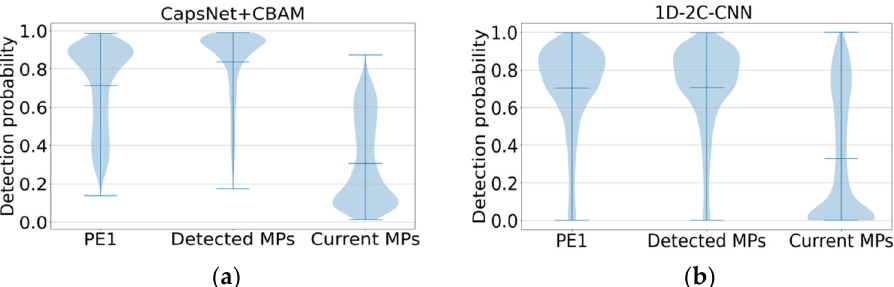
Figure 5. Detectability prediction comparison of peptides with different protein evidence from 3 benchmark test